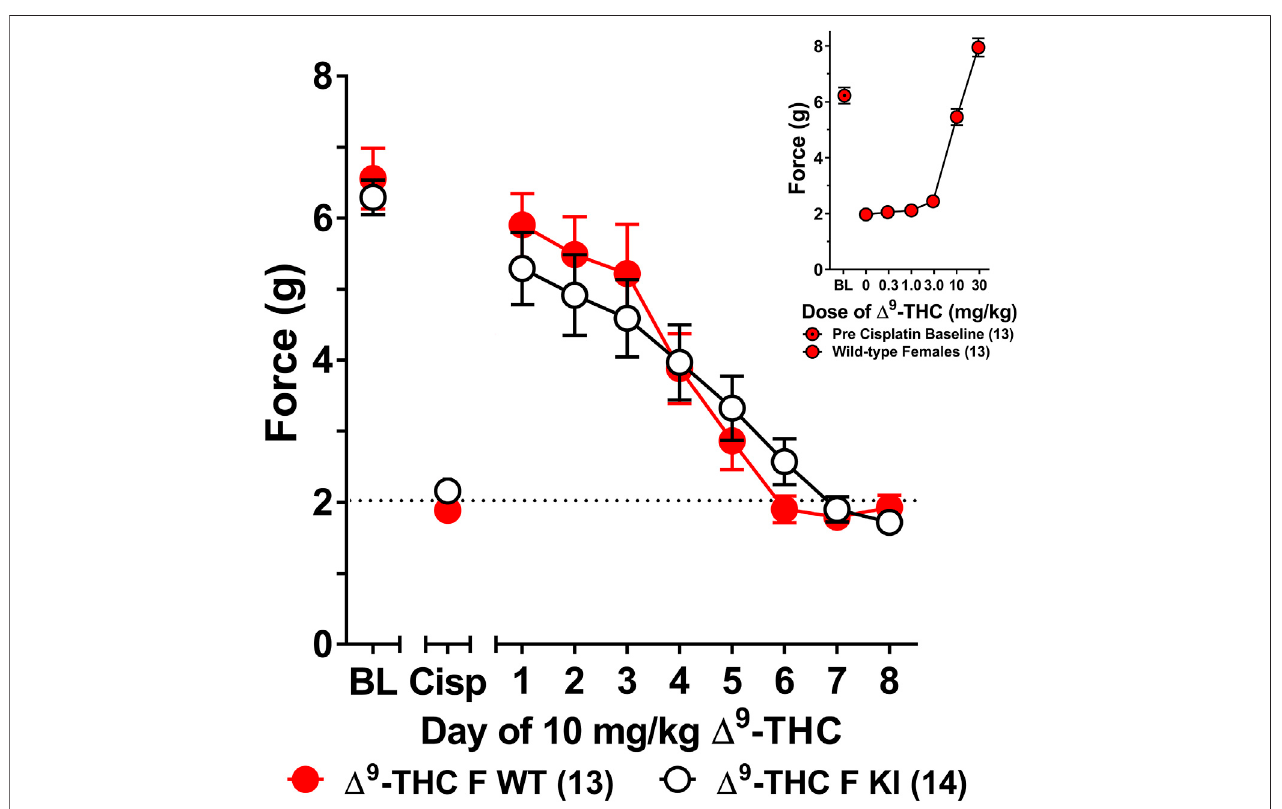
FIGURE 3 | Development of tolerance to the anti-allodynic effects of 10 mg/kg of Δ 9 -THC in female wild-type and S426A/S430A mice. Results from a dose- response (insert) revealed that 10 mg/kg of Δ 9 -THC fully reversed allodynia in wild-type females. Tolerance to the anti-allodynic effects of 10 mg/kg Δ 9 -THC was determinedinfemaleS426A/S430A(KI;un fi lled)and wild-type(WT; fi lled)mice.Micewereassessed usingthevonFreyassayfortheamountofforce(ingrams) required toelicitapawwithdrawalresponse60 minfollowingtreatmentwith6 mg/kg Δ 9 -THC.BLrepresentsthepre-cisplatinbaselineandCISPthepost-cisplatinbaseline. Error bars represent the mean ± SEM. Each mouse was tested in triplicate and those values averaged to determine a single value for each mouse each day of testing. Datawereanalyzedusingseparatetwo-wayANOVAswithBonferronipost-hoctests.Samplesizesforeachgroup(showninparentheses)include13femaleWTmicefor the dose response and 13 female WT and 14 female KI mice for daily